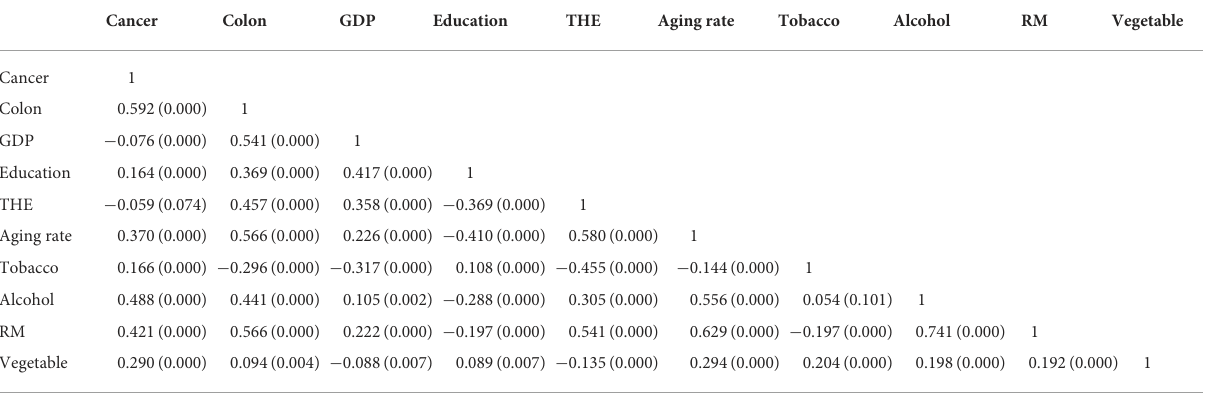
TABLE 2 Correlation matrix of cancer death, the incidence of colon cancer, GDP, education, THE, aging rate, tobacco, alcohol, RM, and vegetable consumption (coefficient and P value).